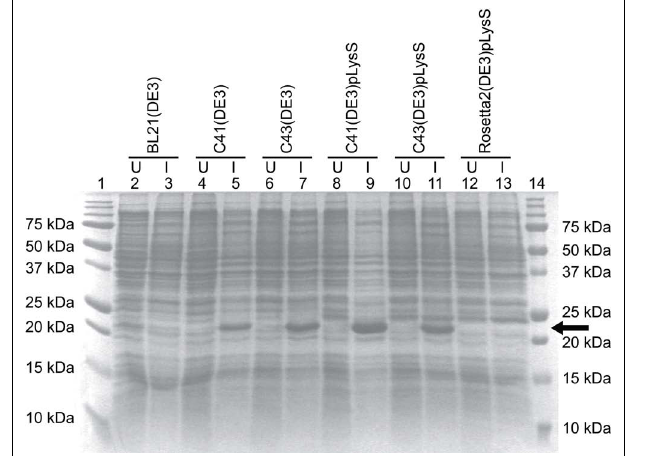
Table 2 | Rare codon usage for eachTM4-CxCT